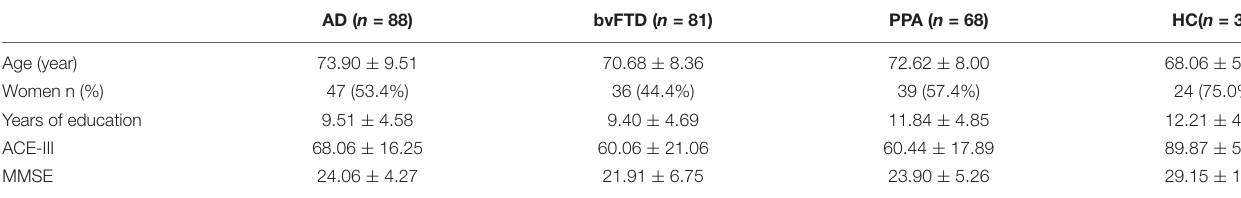
TABLE 1 | Main demographic